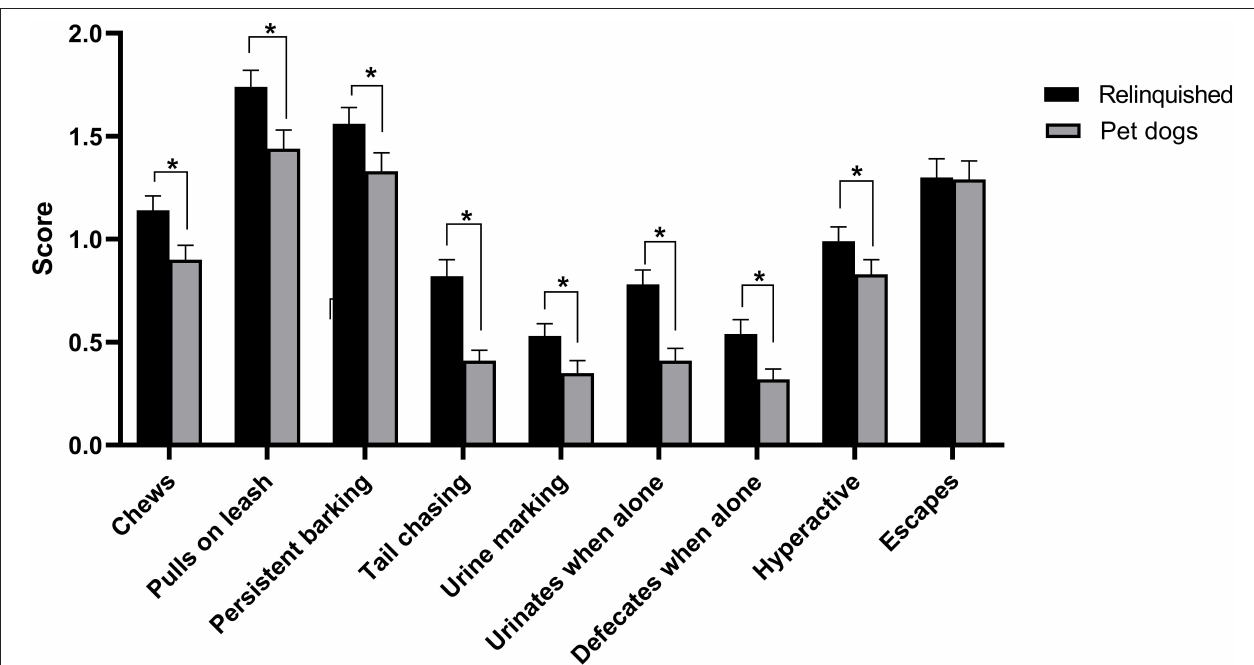
FIGURE 4 | C-BARQ miscellaneous questions between relinquished and pet dogs. Data are shown as mean ± SEM. * indicates statistical significance ( p <